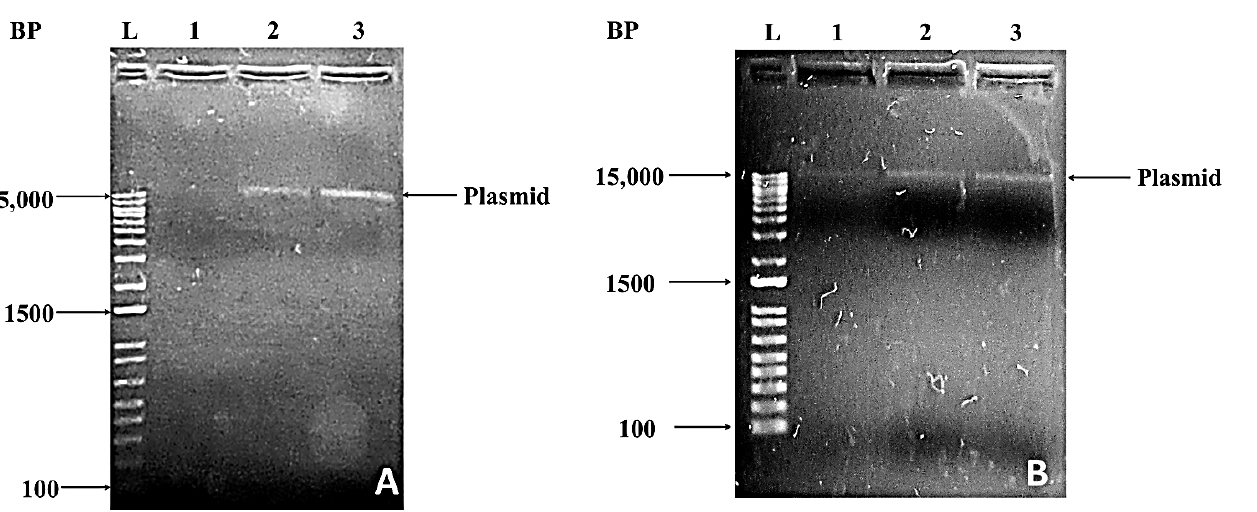
Figure 4. A total of 1.2% agarose gel electrophoresis of plasmid preparation from bacterial isolates BR3 ( A ) and BR4 ( B ). Lanes 1–3 represent the plasmid preparation from culture grown in 1: